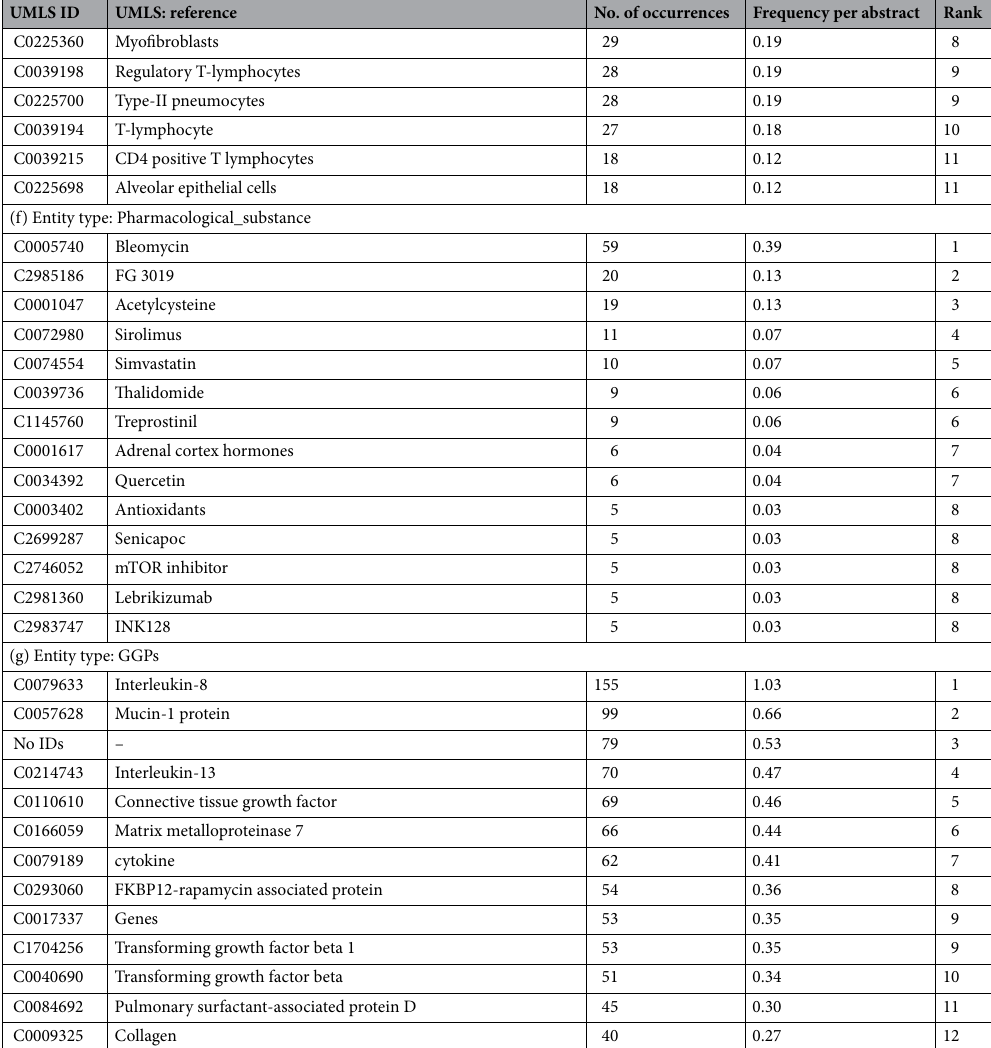
Table 4. Frequently observed UMLS IDs with the UMLS reference for each entity